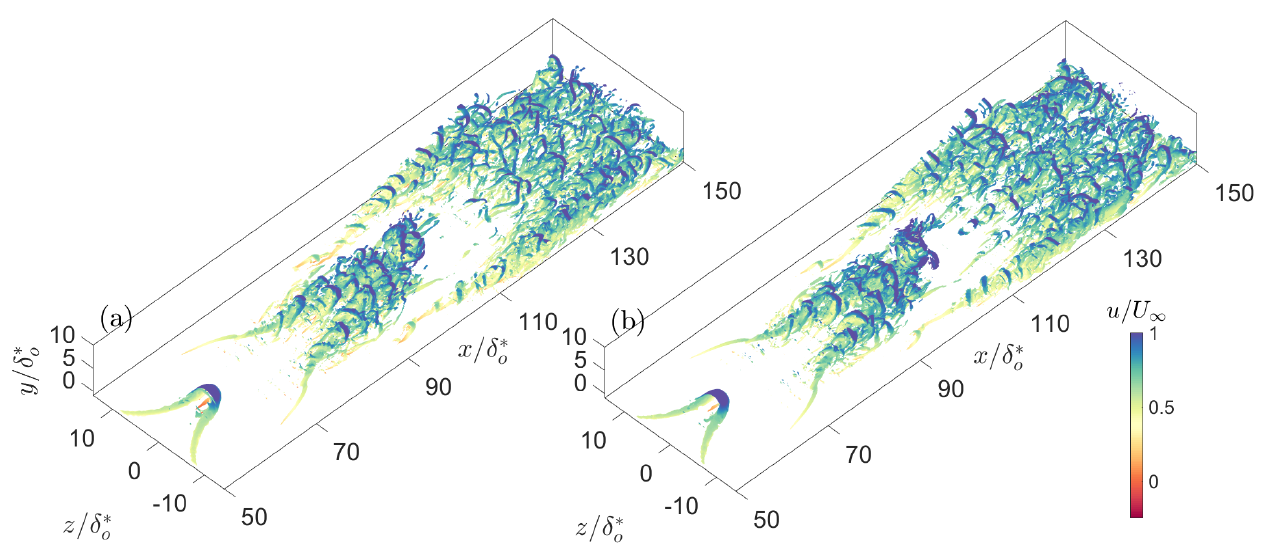
Figure 4. Large step. Isosurfaces of λ 2 , colored by the magnitude of streamwise velocity, u / U ∞ ; λ 2 = − 3.0 × 10 − 2 . ( a ) Full domain; ( b ) half